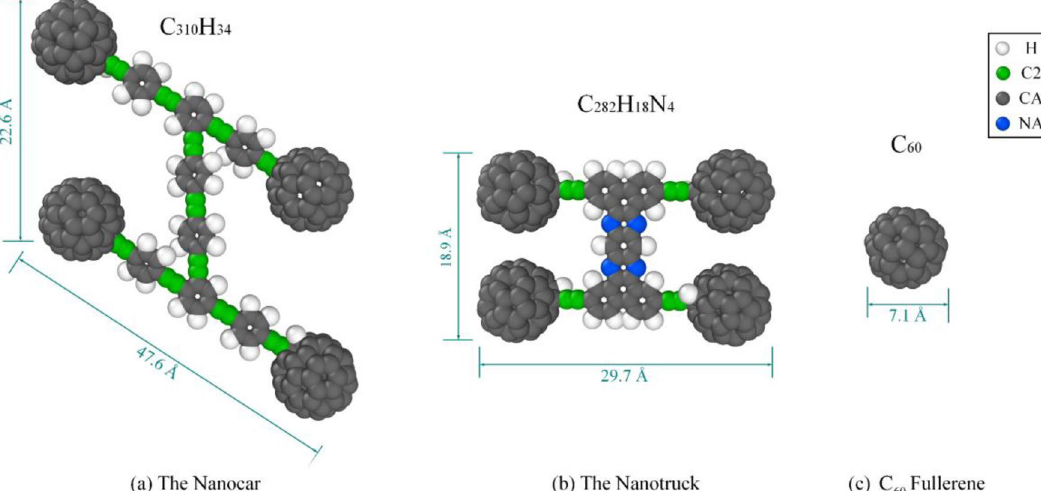
Figure 1. Schematic representation of ( a ) the nanocar, ( b ) the nanotruck, and ( c ) C 60 fullerene. The molecular dimension is indicated for each molecule in the figure. A C 60 has a molecular weight of 720.642 g mol , while the molecular weight of a C 60 -based nanocar and nanotruck is 3757.587 g mol and 3602.202 g mol , respectively 22